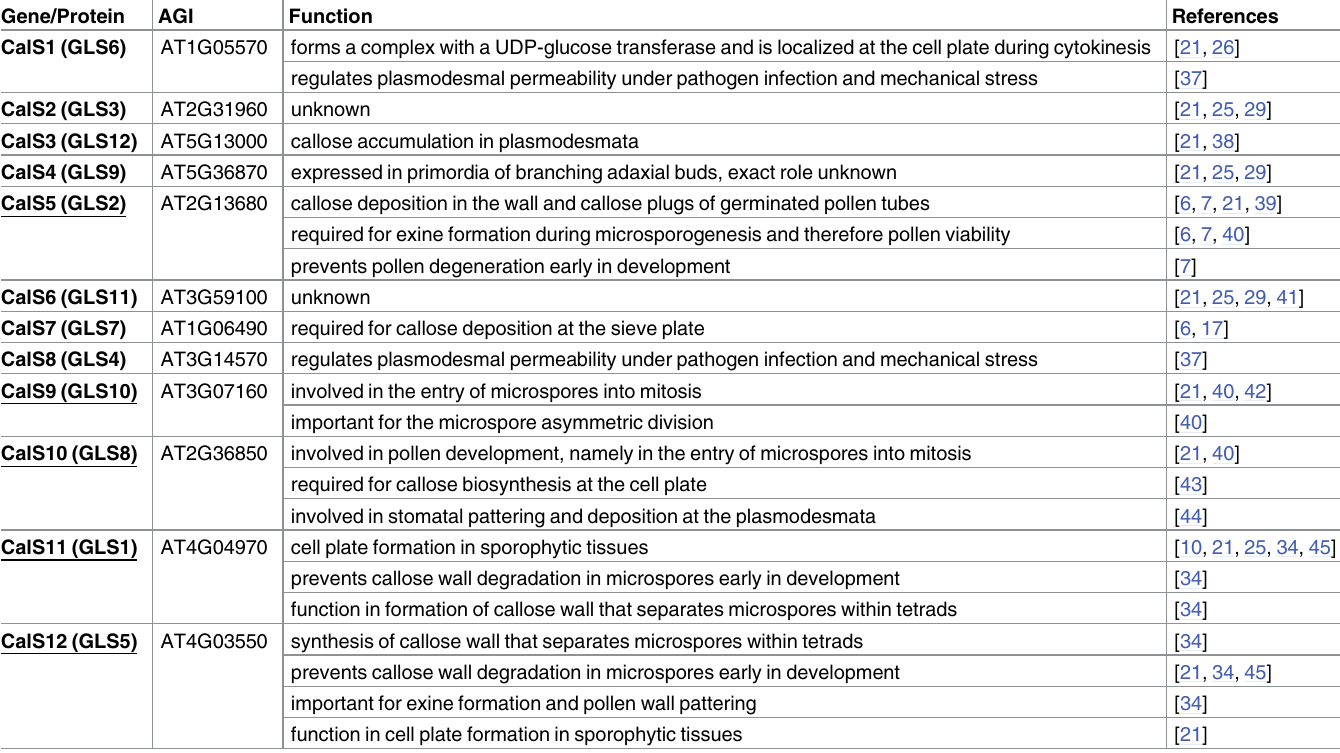
Table 1. Summaryof callose synthase proteins their function, and location in the Arabidopsis thaliana . Proteins active in pollenare underlined. Gene/Protein AGI Function CalS1